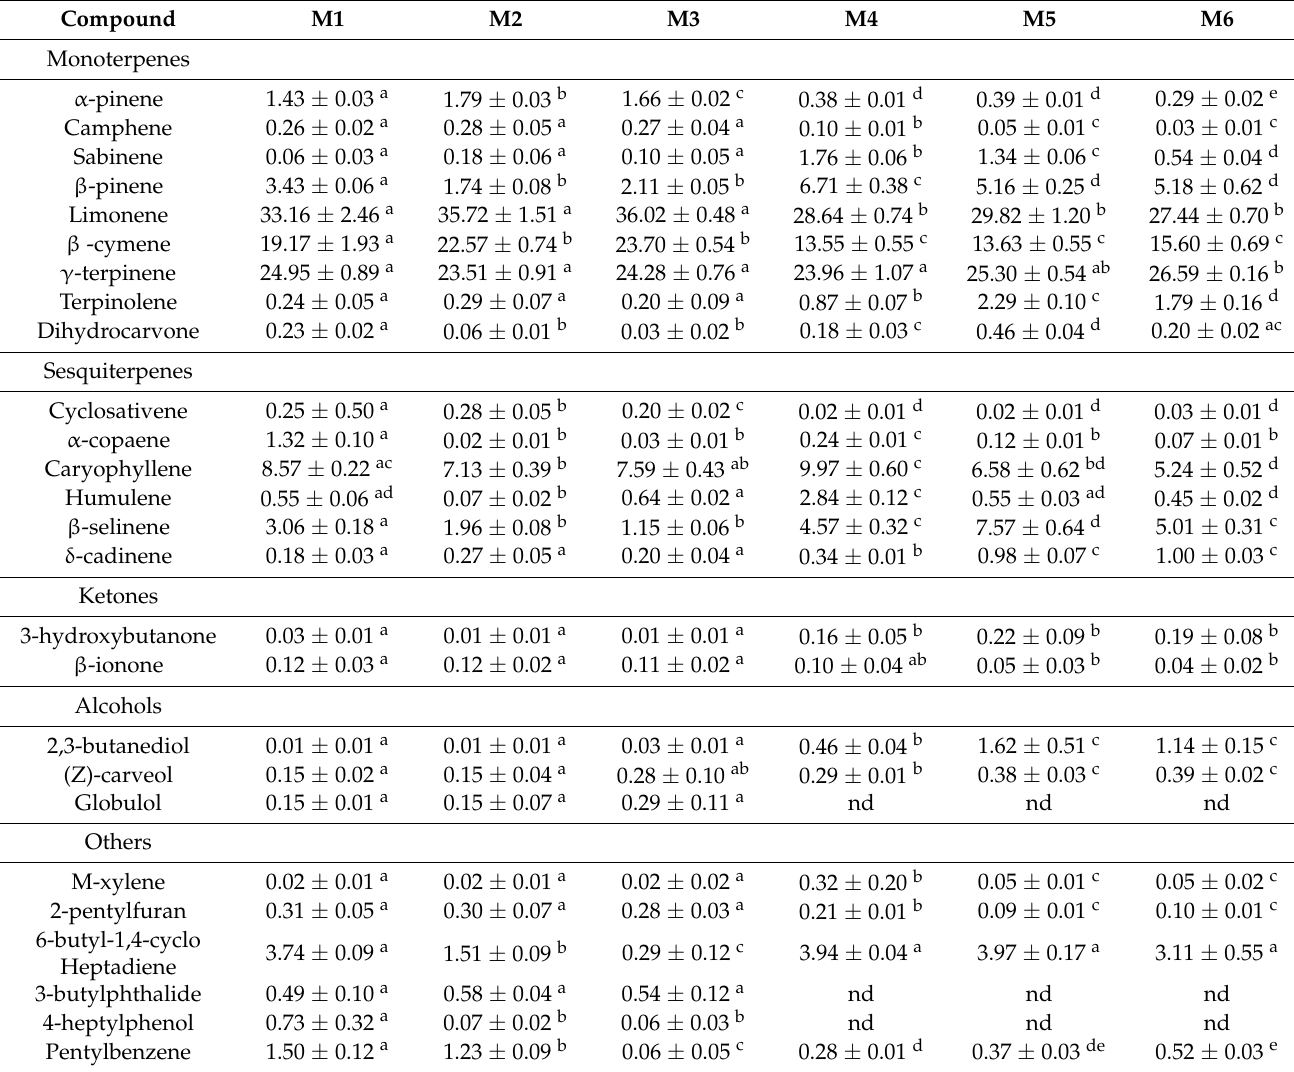
Table 3. Relative abundance (%) of volatile compounds in stalk (M 1 , M 2 and M 3 ) and root (M 4 , M 5 and M 6 ) celery wastes.